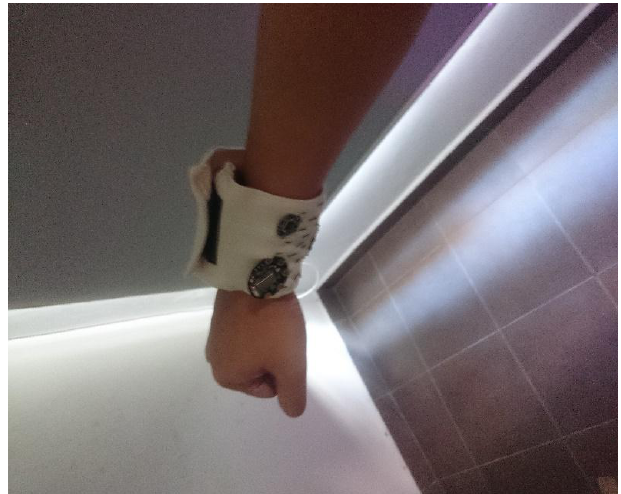
Figure 3. A wearable accelerometer to track movements RMS The participants were divided into 3 groups